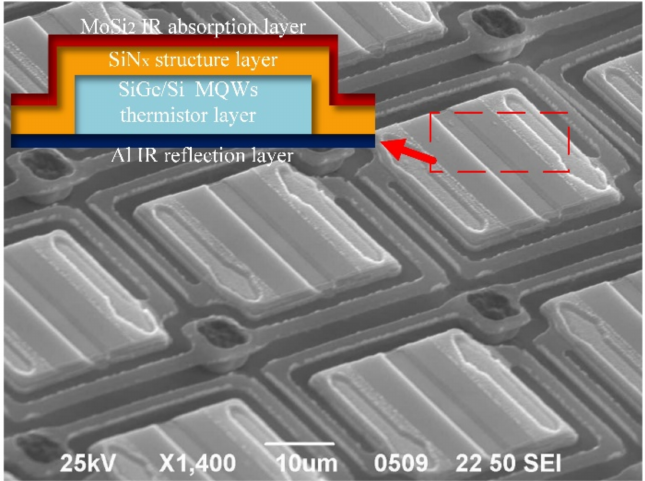
Figure 2. L-type SiGe/Si MQWs micro-bolometer and its infrared-absorption structure